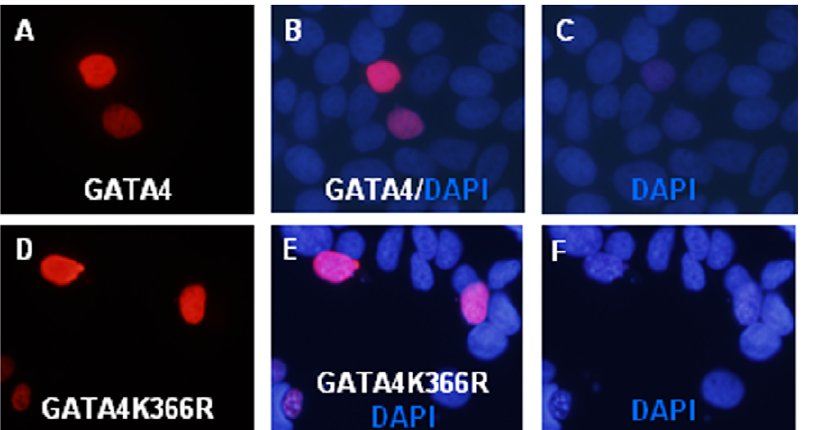
Figure 7. Sumoylation is not required for nuclear localization of GATA4. HCT116 cells plated on coverslips were transfected with HA epitope tagged GATA4 (panels A,B,C) or K366R mutated GATA4 (panels D,E,F). Cells were fixed, permeabilized and stained with rabbit HA antibody and Alexa 594 conjugated anti rabbit secondary antibody. Coverslips were mounted with DAPI-containing mounting media and analyzed for